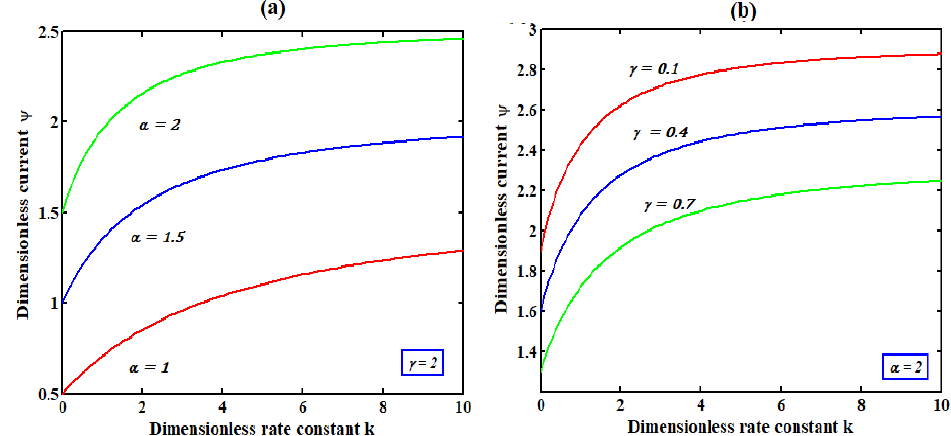
Figure 4. ( a , b ): Dimensionless current versus dimensionless rate constant 𝑘 . Table 1. Comparison between the numerical and analytical expression of the concentration of the substrate obtained by AGM and DTM for the parameters 𝛼 = 0.8, 𝛾 = 0.5, and for different val- ues of k .